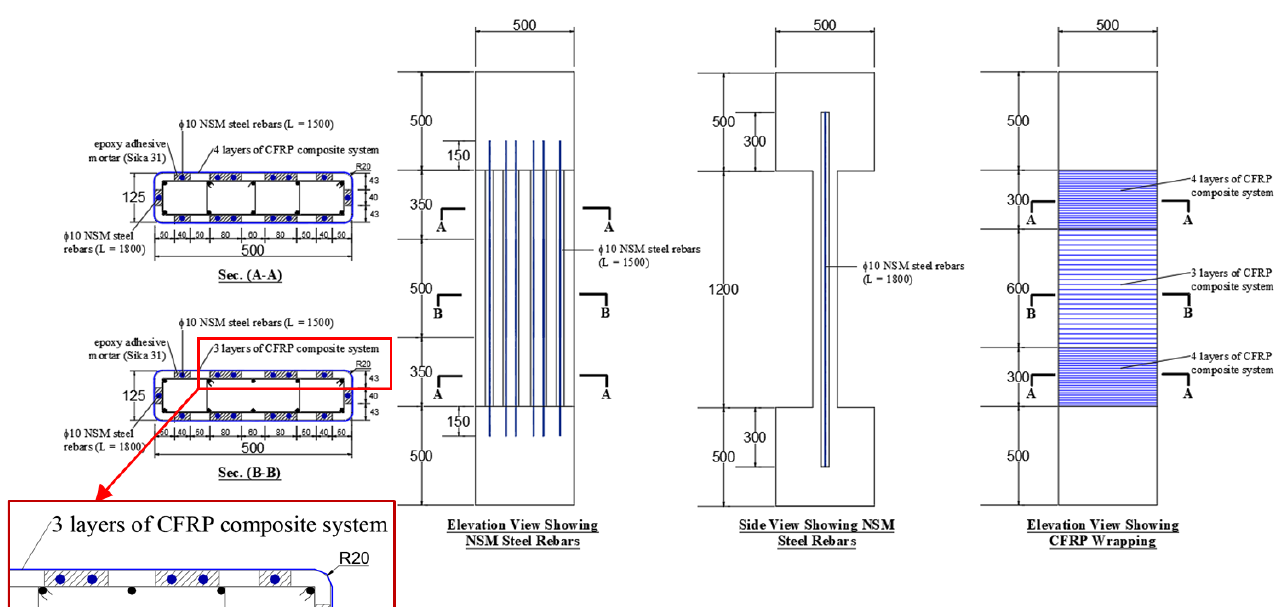
Figure 3. Dimensions and reinforcement detailing of strengthened specimen SW2 (note: all dimen- sions are in mm).